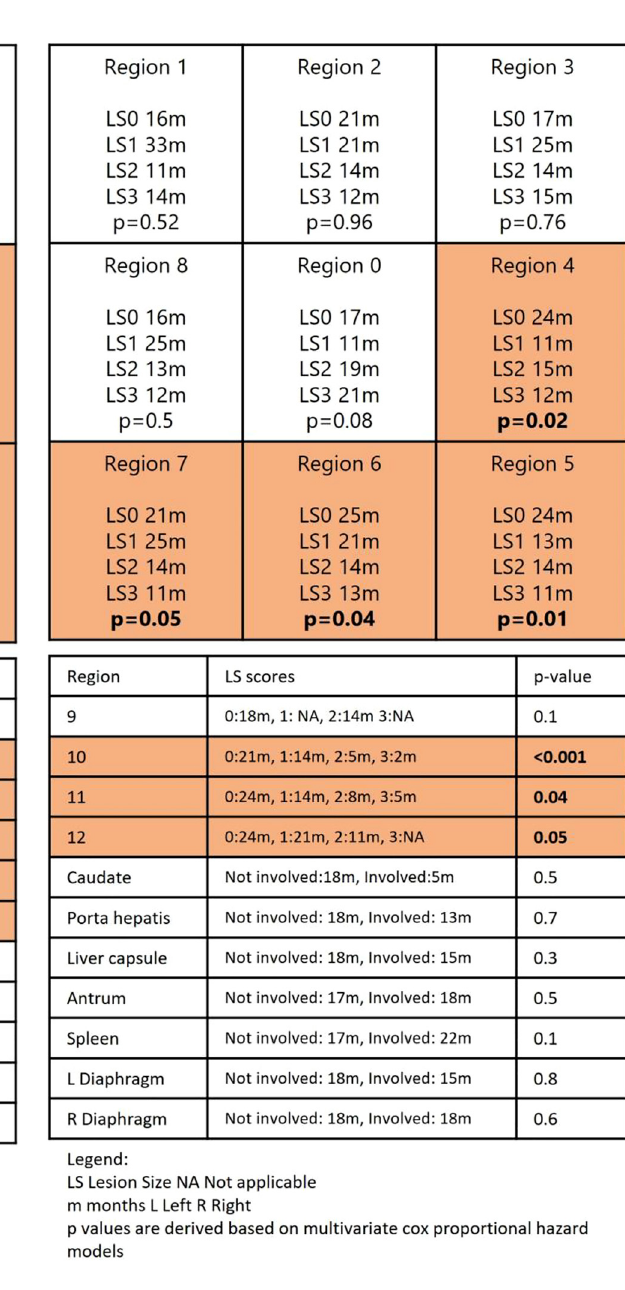
Figure 4: PCI distribution/lesion size (LS) score and overall survival (months).